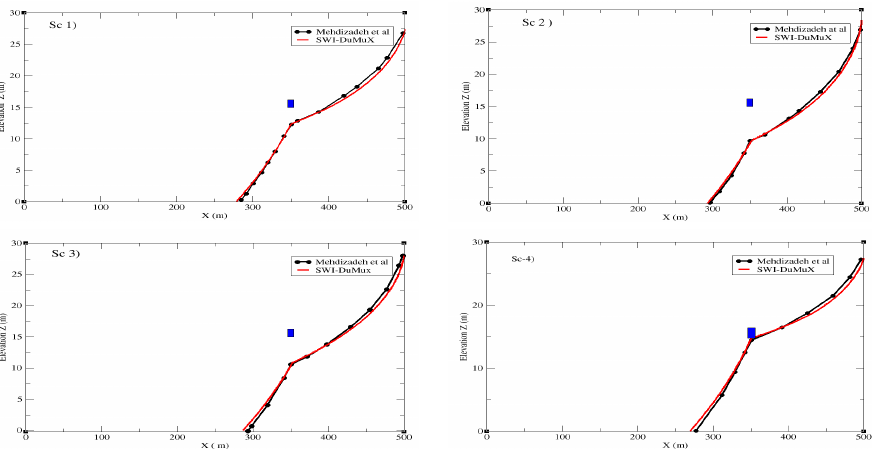
Figure 3. Evolution of the salt front by varying the pumping rate and fixing the position of the